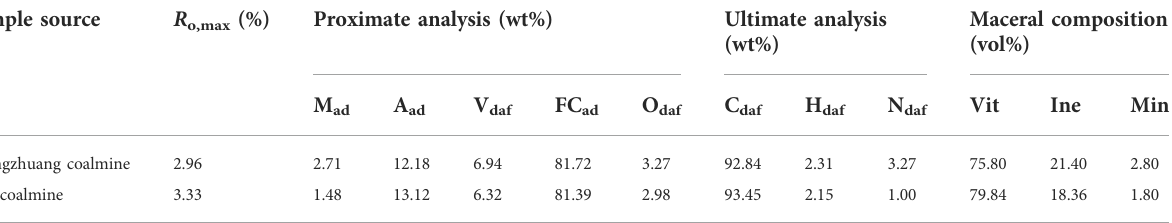
TABLE 1 The basic information of samples used in this work. Sample source